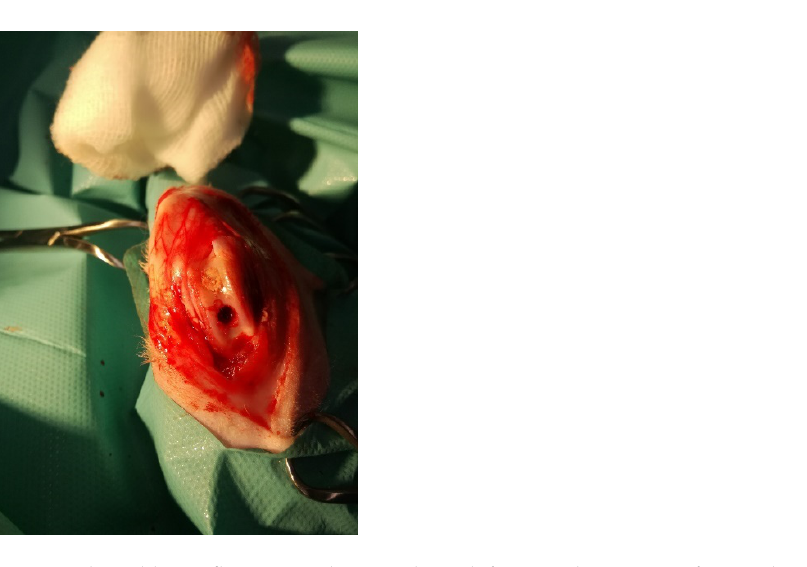
Figure 1. The rabbit stifle joint with a cartilage defects in the course of osteochondral autograft transplantation.